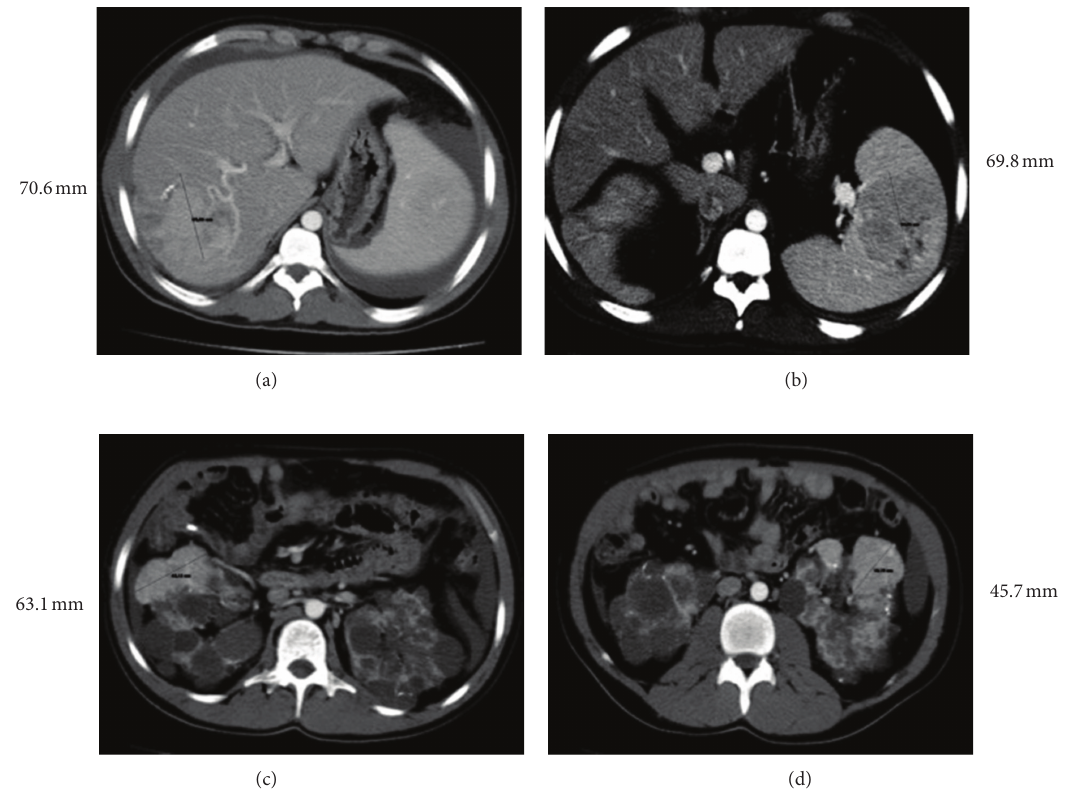
F 1: Abdominal CT (prior to renal transplantation) showing different lines of tumours in liver, spleen, and